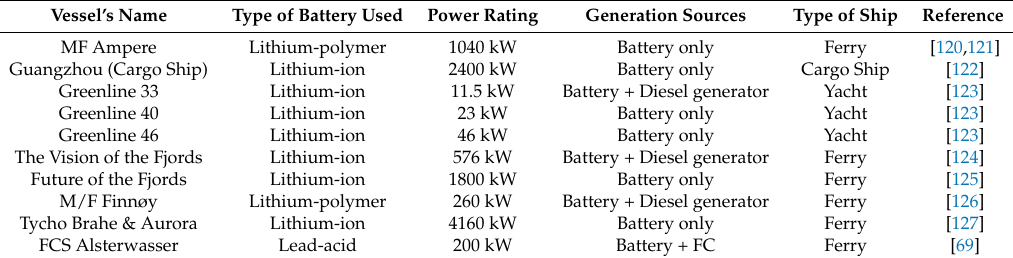
Figure 23. Fuel cell ship (FCS) alsterwasser hybrid battery/fuel cell system [130]. Table 8. Summary of BESS-based